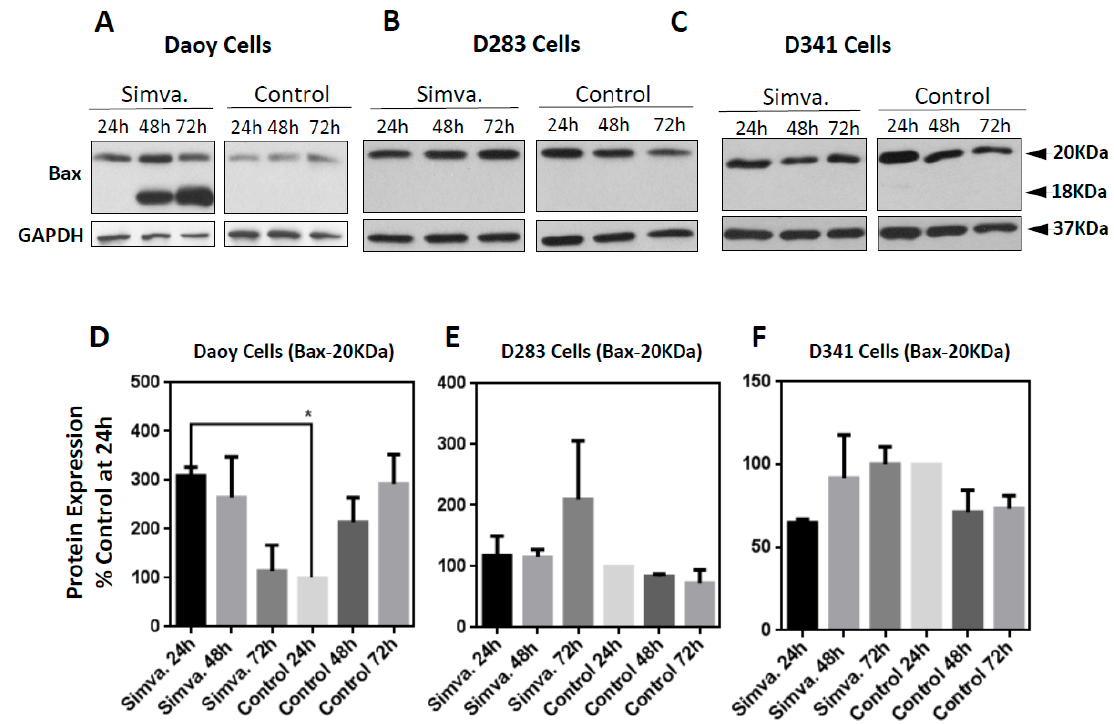
Figure 8. Simvastatin-induced expression of Bax is cell line-specific. Daoy ( A , D ), D283 ( B , E ), and D341